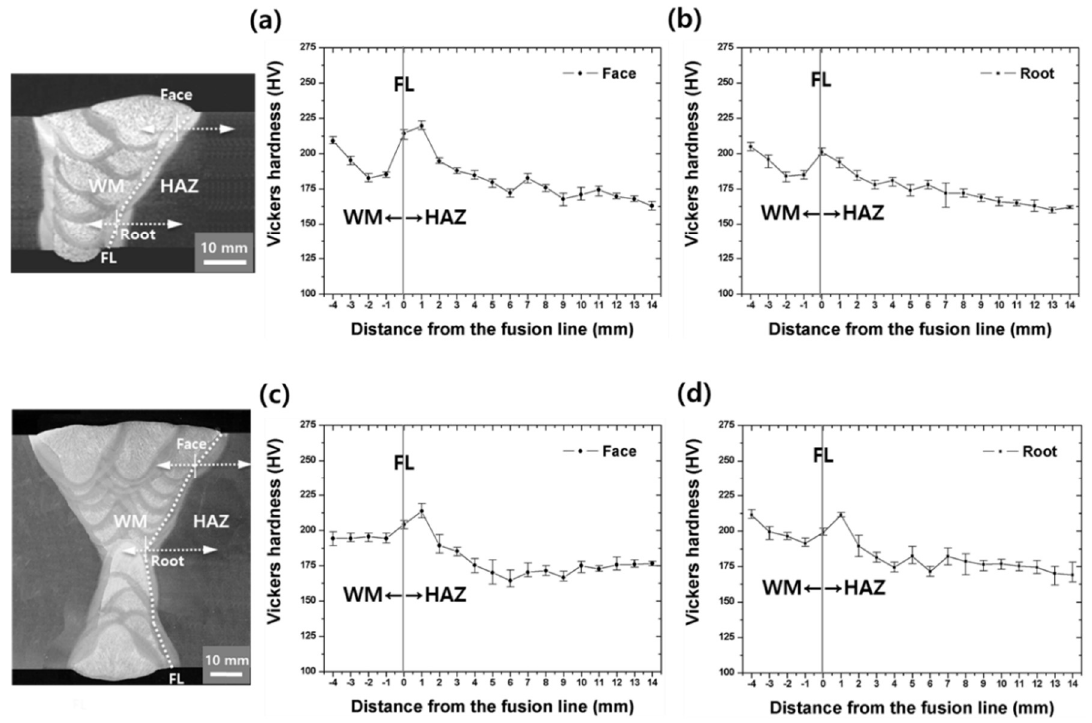
Figure 7. Hardness test results: The butt-joint manufactured by FCAW with the 30 mm thick plate, ( a ) face; ( b ) root. The butt-joint manufactured by SAW with the 70 mm thick plate, ( c ) face; ( d ) root.